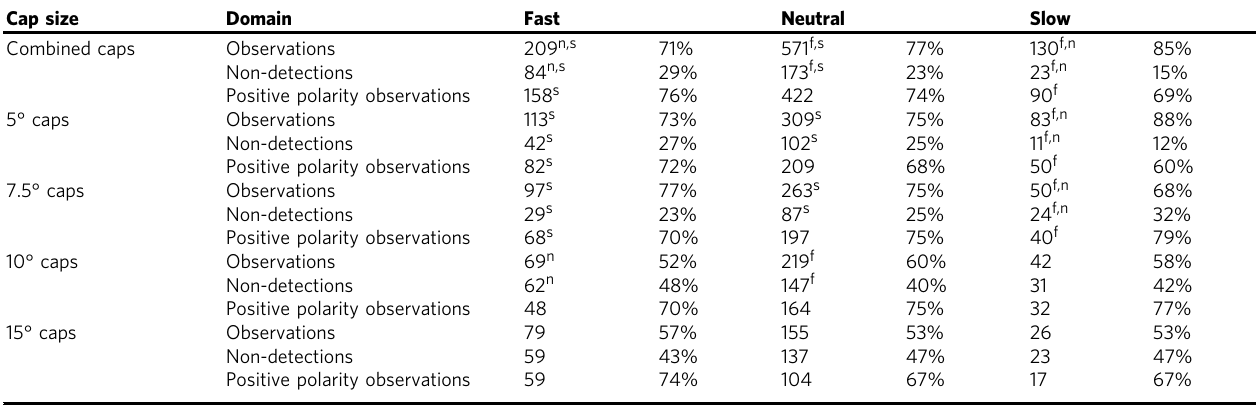
Table 1 Quantity and percentage of re fl ector observations and polarity Cap size Domain Fast Combined